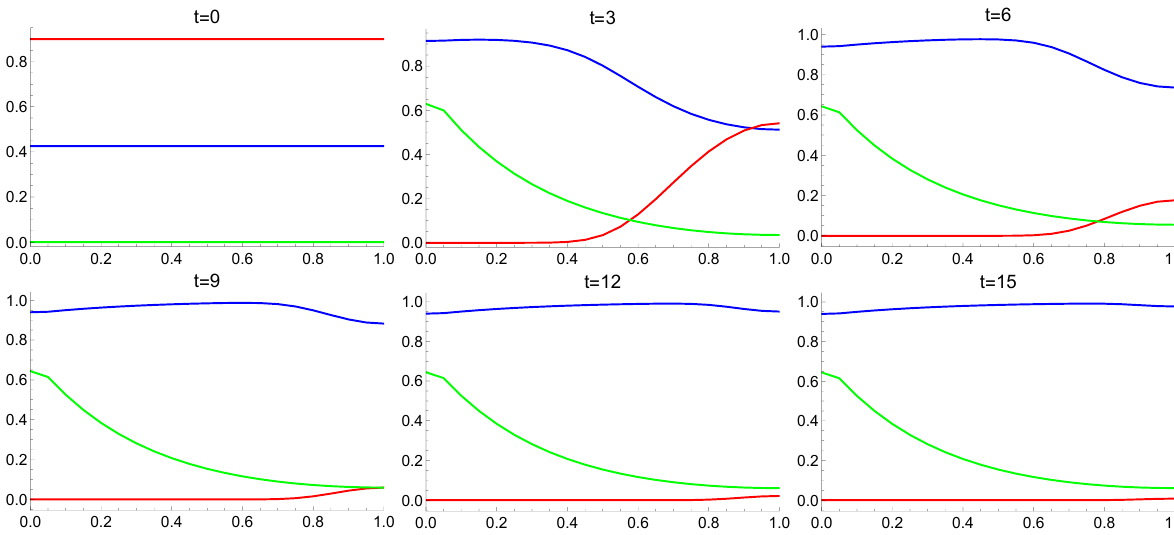
Fig. 5 Results of Simulation 5, with Ω = [ 0 , L ] = [ 0 , 1 ] . Plots of model solutions A ( x , t ) (cancer cells, red), N ( x , t ) (normal cells, blue) and D ( x , t ) (chemotherapeutic drug concentration, green) at time points t = 0 , 3 , 6 , 9 , 12 , 15. See Table 1 for parameter values used here. At time t = 0, the tumor is spread trough the tissue, and as chemotherapy is applied ( t > 0), the tumor cells are reduced and in the entire tissue. In comparison with Simulation 2, the tumor extinction is reached because the chemotherapy toxicity against tumor cells, α A , was